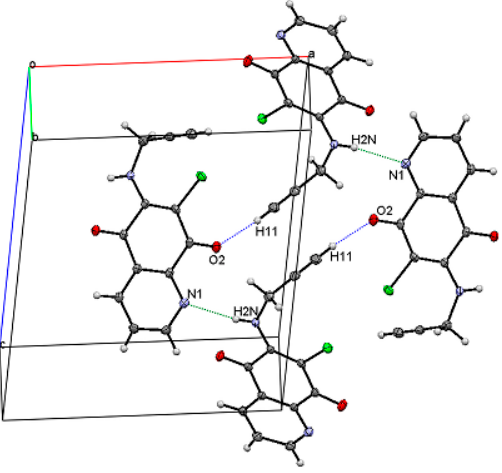
Figure 3. Crystal structure and hydrogen bonds in of 7-chloro-6-propargylamine-5,8-quinolinedione 3a .